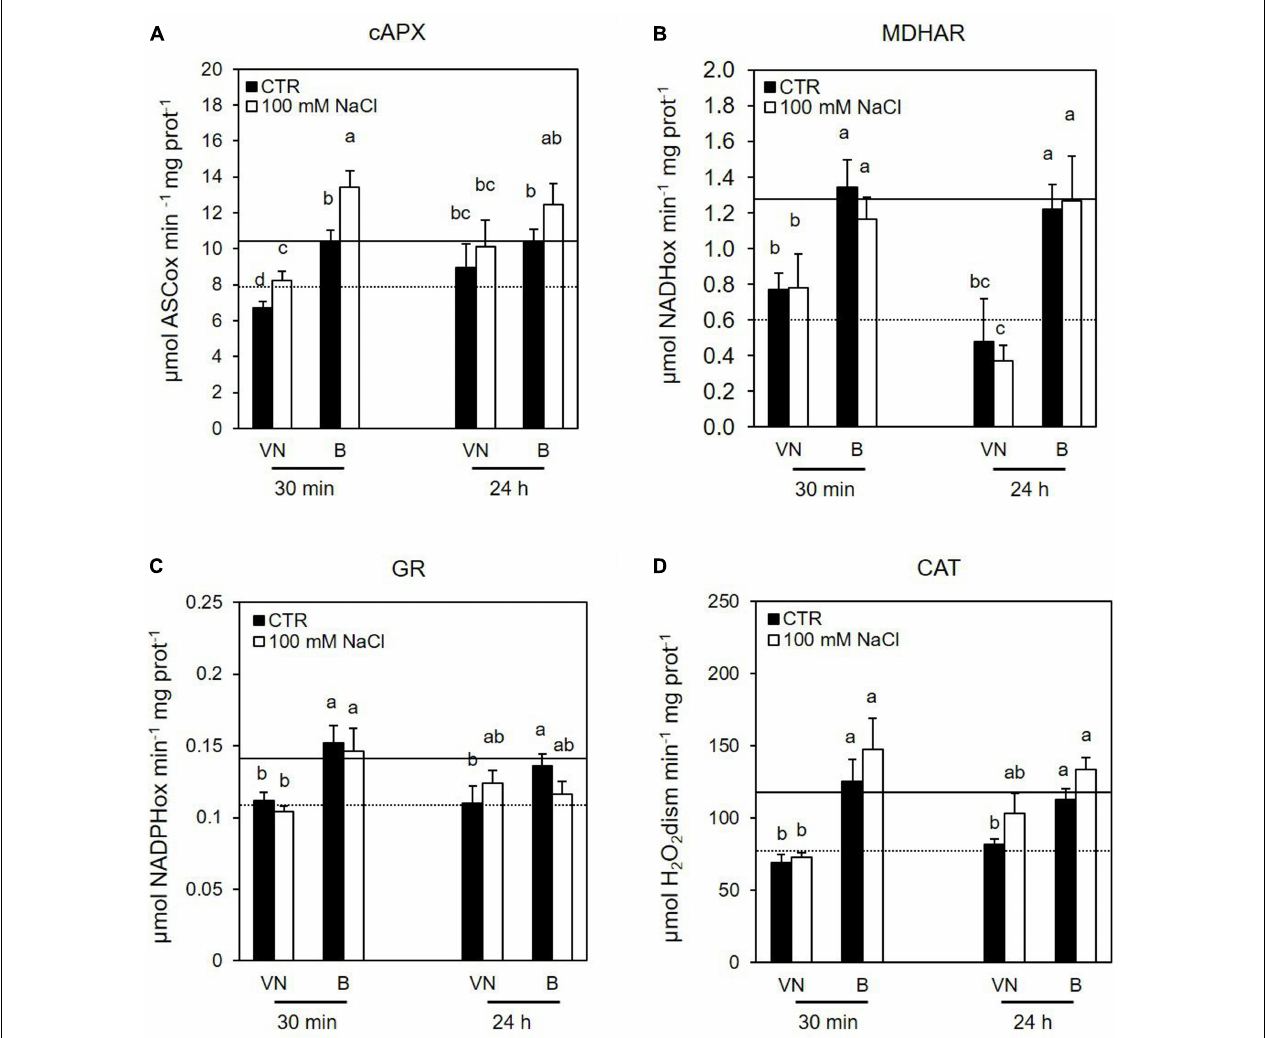
FIGURE 7 | Effects of 100 mM NaCl on (A) cAPX, (B) MDHAR, (C) GR, and (D) CAT activity determined at 30 min and 24 h after treatment. Values represent the mean ± SE of three independent experiments. The lines represent average enzymatic activity in control conditions of VN (straight line) and B (dotted line). Different letters indicate significantly different activity levels according to one-way ANOVA ( p <